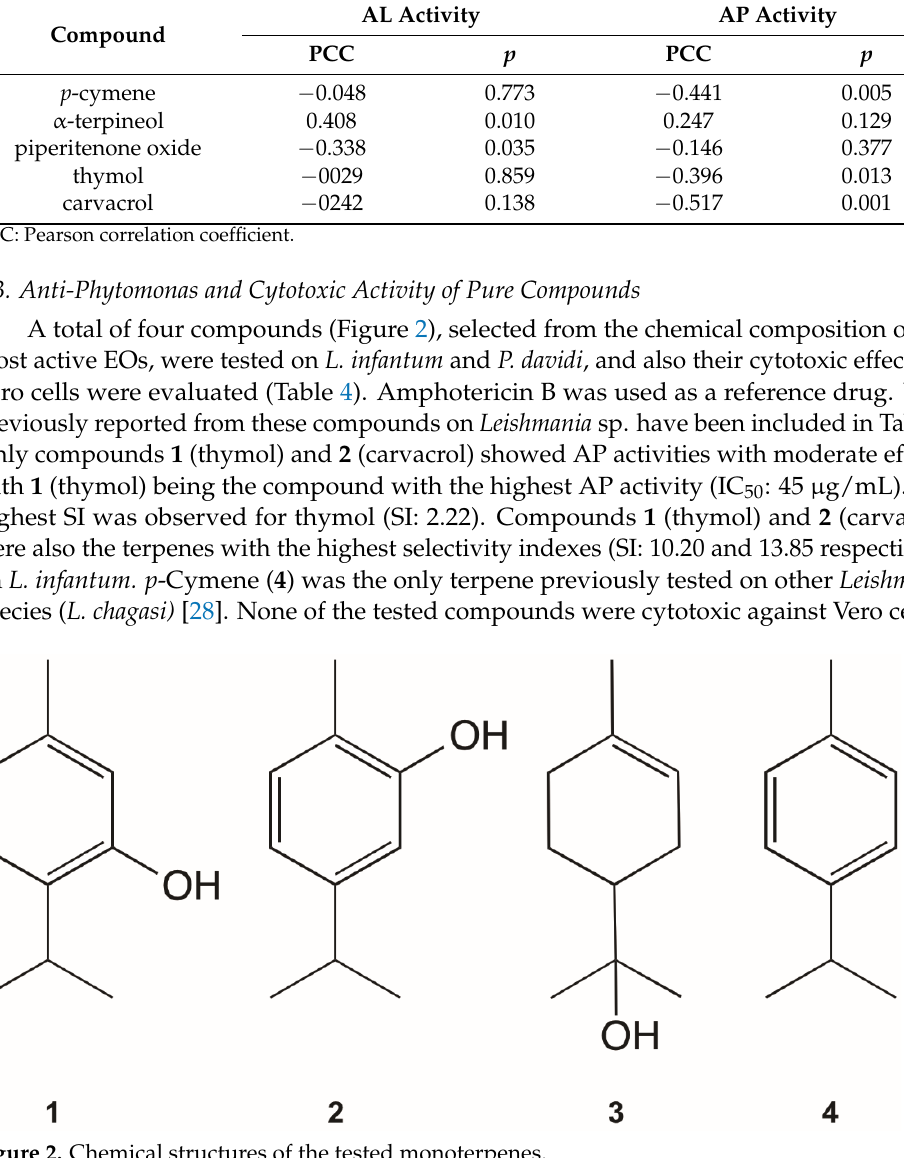
Figure 2. Chemical structures of the tested monoterpenes. Table 4. Effects of the tested compounds on P. davidi, L. infantum , and Vero cells (IC 50 and CC 50 respectively).